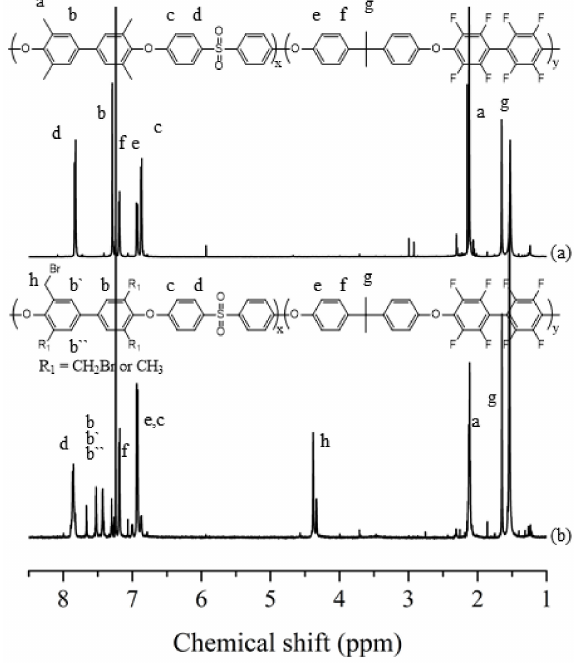
Figure 2. 1 H-NMR of ( a ) PAES, ( b ) Br-PAES.